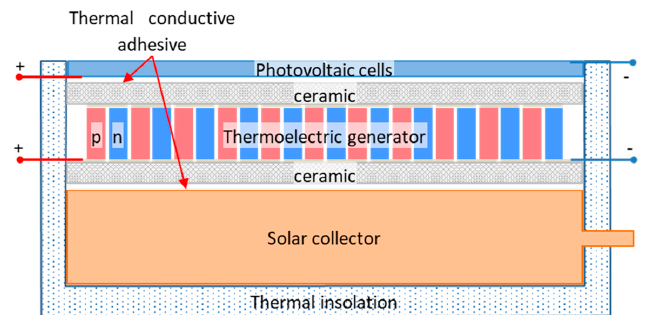
Figure 3. PV-TEG-T structure.